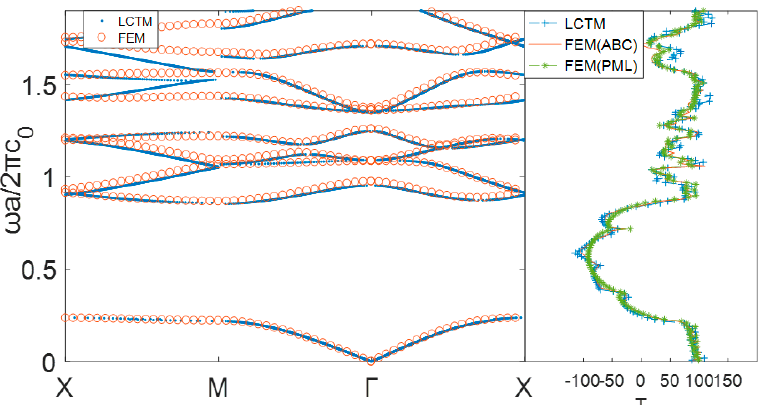
Figure 19. Nodes distribution for ( a ) the unit cell of phononic crystal with a hexagon matrix including a square scatterer; ( b ) Node distribution with error region and element distribution with PML region for the phononic crystal with semi- infinite periodic structure in the y-direction.